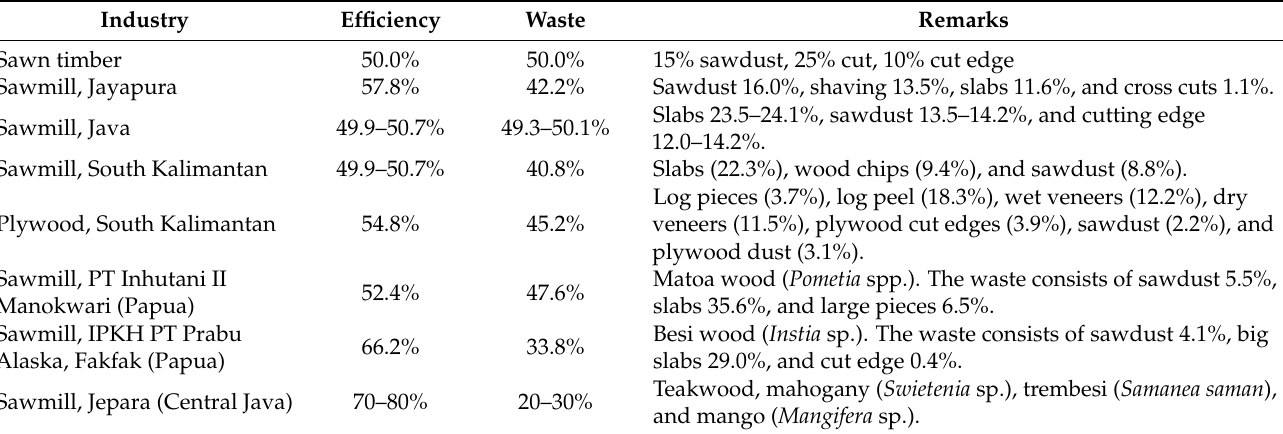
Table 3. The efficiency of Wood Industries in